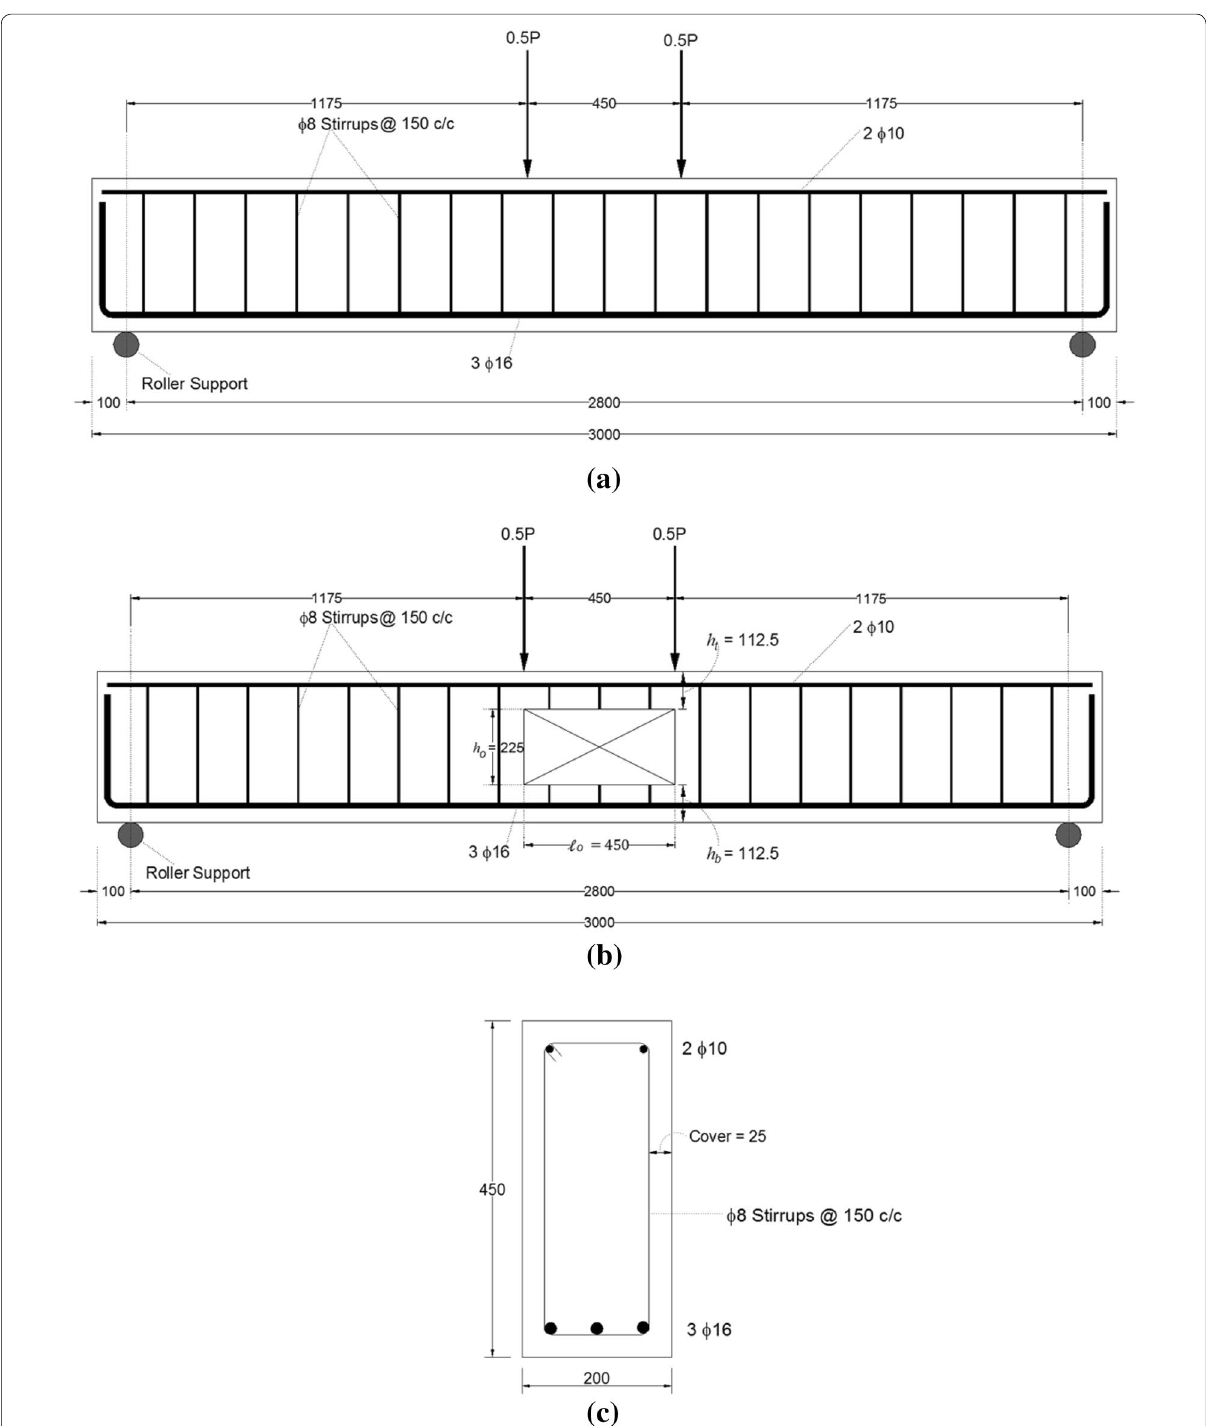
Fig. 2 Details of unstrengthened beams with 4‑point bending (Note: all dimensions are in mm): a elevation of BC‑N‑4PB, b elevation of beam BC‑O1‑4PB, and c beam